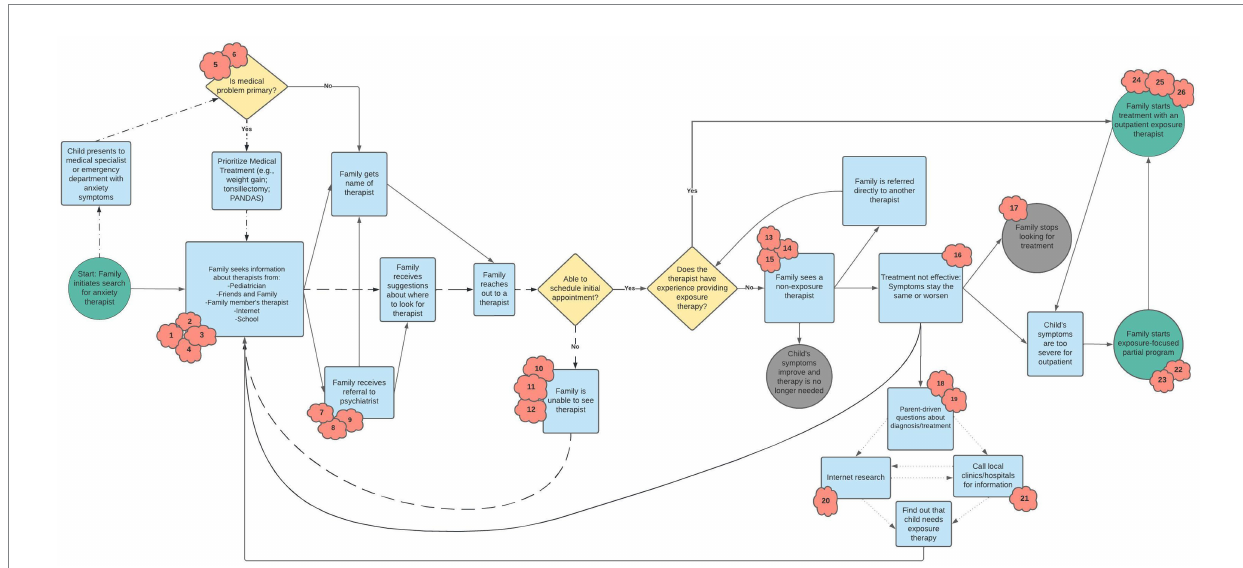
FIGURE 1 Final combined process map. Detailed descriptions of red clouds are provided in Table 2. Consistent with Kim and colleagues (31), each shape connotes a different type of step in the process: (a) Circles represent a process' start and end points; (b) Arrows between shapes depict the sequence in which events occur; (c) Rectangles indicate events that took place in the process; (d) Diamonds represent decision points in the process; and (e) Cloud shapes (referred to as "kapowies" during focus groups) represent uncertainties, gaps, bottlenecks, or inefficiencies. Loops are identified by different pattern lines: (a) the medical loop is represented by dashes and dots; (b) the search-outreach loop is represented by dashes; and (c) the parent research loop is represented by small